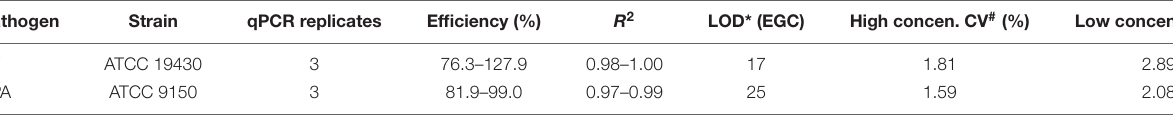
TABLE 1 | Performance of S. Typhi and S. Paratyphi qPCR assays † and DNA standards. Pathogen